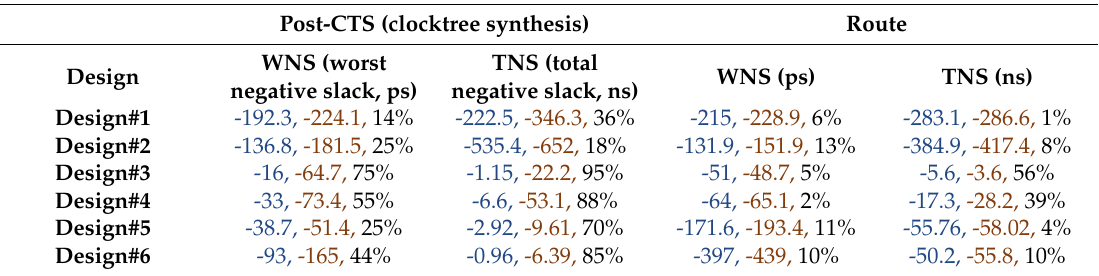
Table 5. Quality of results (QoR) summary.